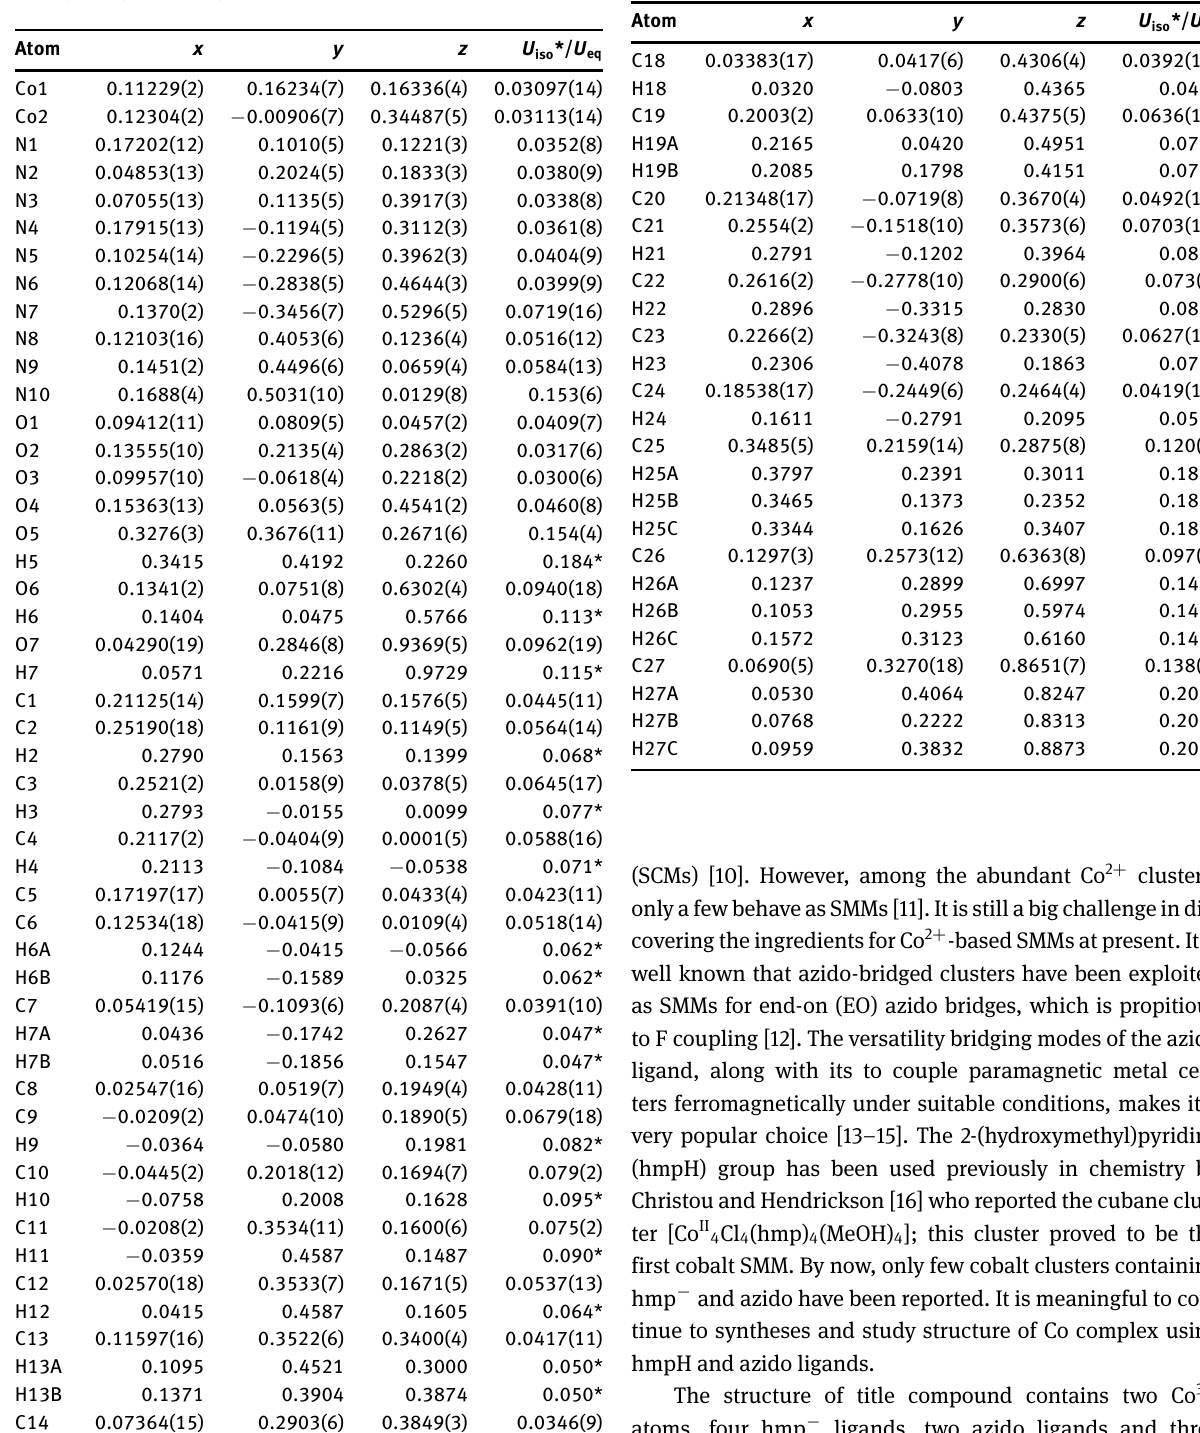
Table 2: Fractional atomic coordinates and isotropic or equivalent isotropic displacement parameters (Å 2